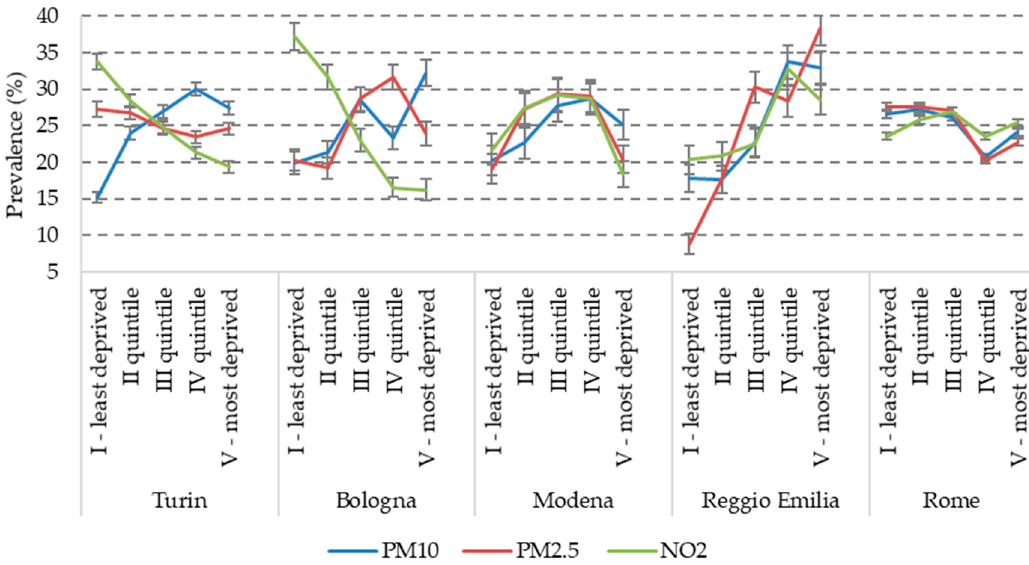
Int. J. Environ. Res. Public Health 2020 , 17 , x Figure 3. Prevalence of high air pollution exposure ( > 75th percentile) by city and maternal citizenship. Figure 3. Prevalence of high air pollution exposure (>75th percentile) by city and maternal citizenship.